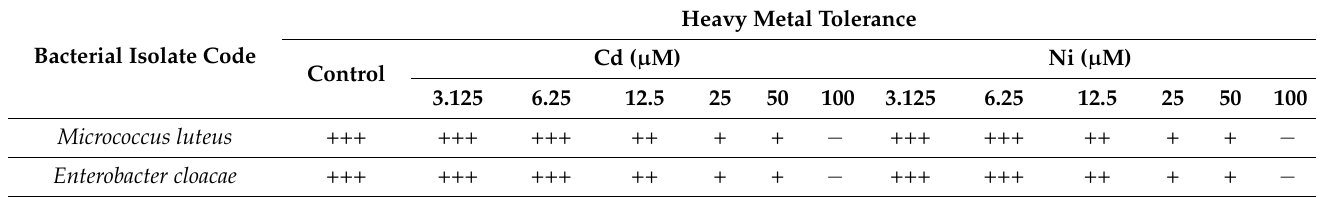
Table 4. Heavy metal resistance behavior of the most potent plant growth promoting endophytic bacterial isolate; +++ (normal growth); ++ (moderate growth); + (weak growth); − (no growth).